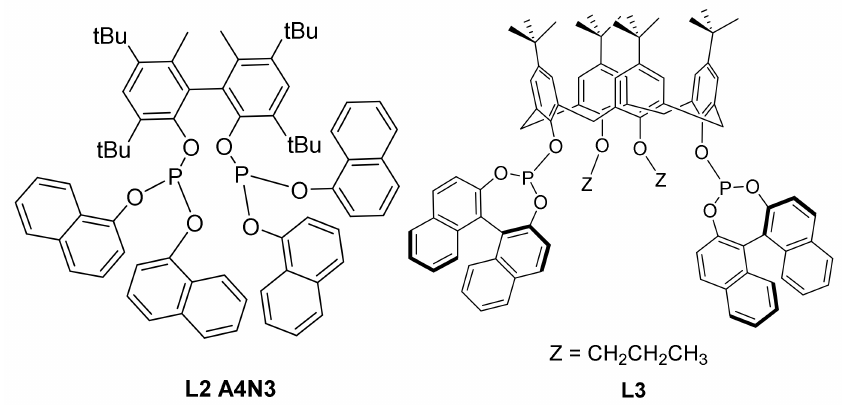
Figure 8. Other biphosphite ligands investigated in the tandem isomerization-hydroformylation of